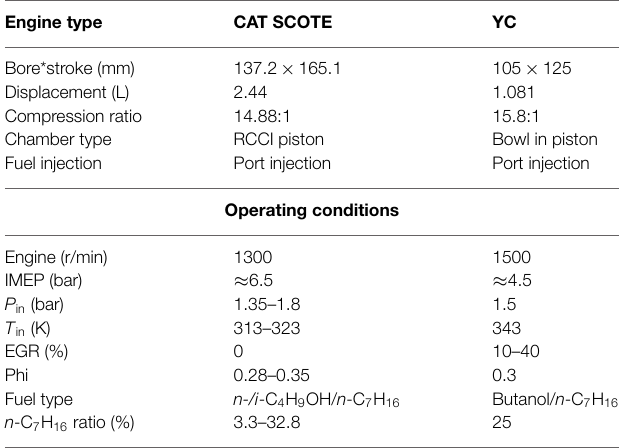
TABLE 3 | Engine specifications and HCCI operating conditions